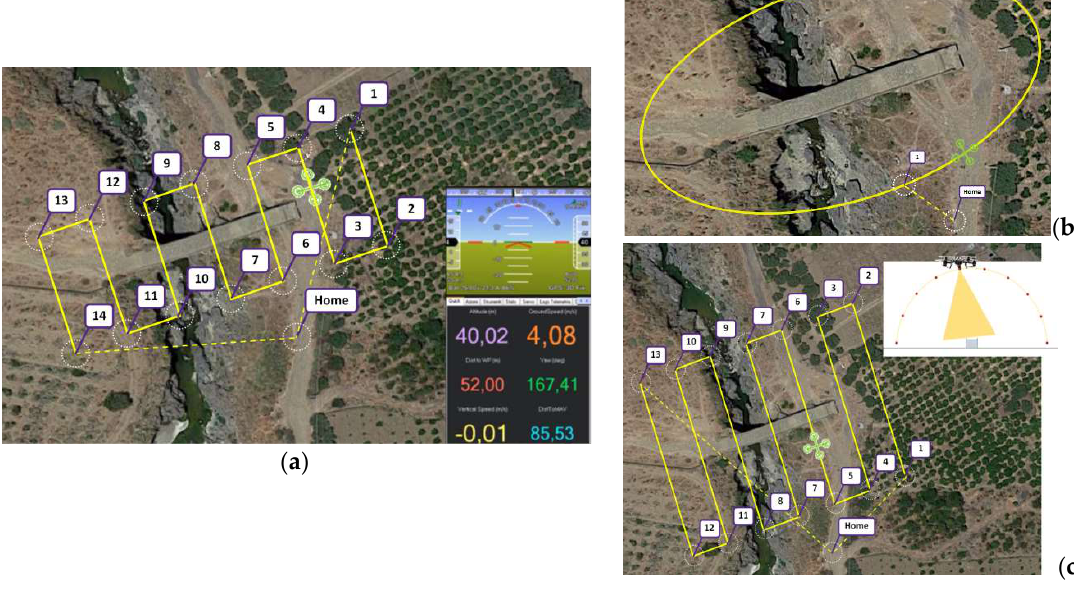
Figure 2 . Waypoint acquisition grids: ( a ) Rectangular at ℎ (cid:3049) = 40 m; ( b ) Elliptical at ℎ (cid:3049) = 30 m; ( c ) Figure 2. Waypoint acquisition grids: ( a ) Rectangular at h v = 40 m; ( b ) Elliptical at h v = 30 m; Cylindrical ℎ (cid:3049) = 40 m. ( c ) Cylindrical h v = 40